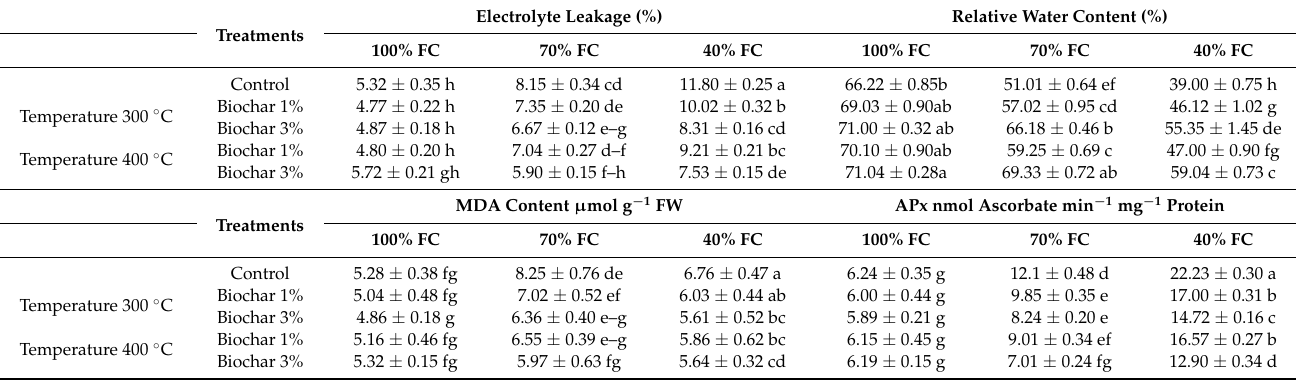
Table 3. The effect of biochar on electrolyte leakage, relative water content, MDA content and APx activity in maize plants under drought